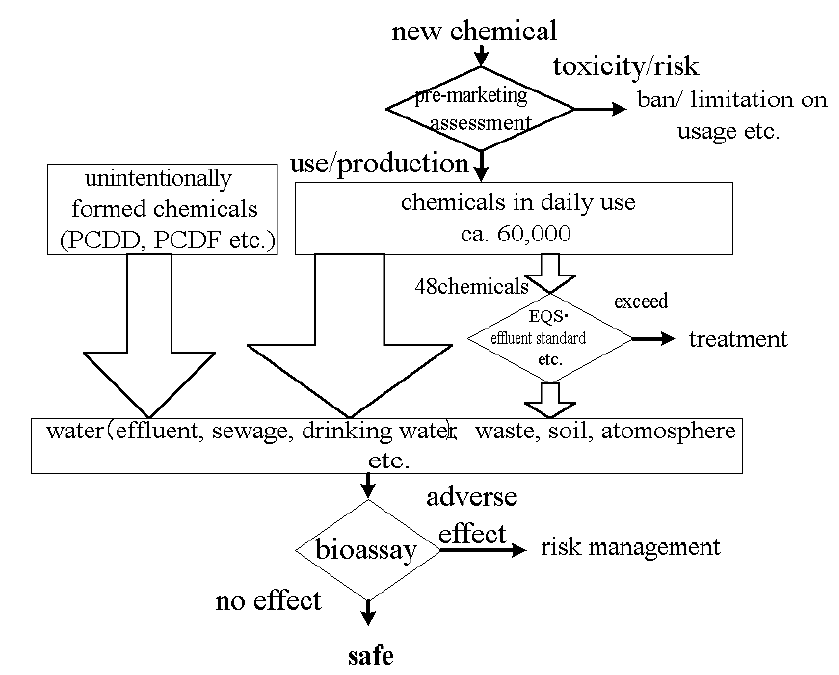
FIGURE 2 . Role of bioassays in environmental